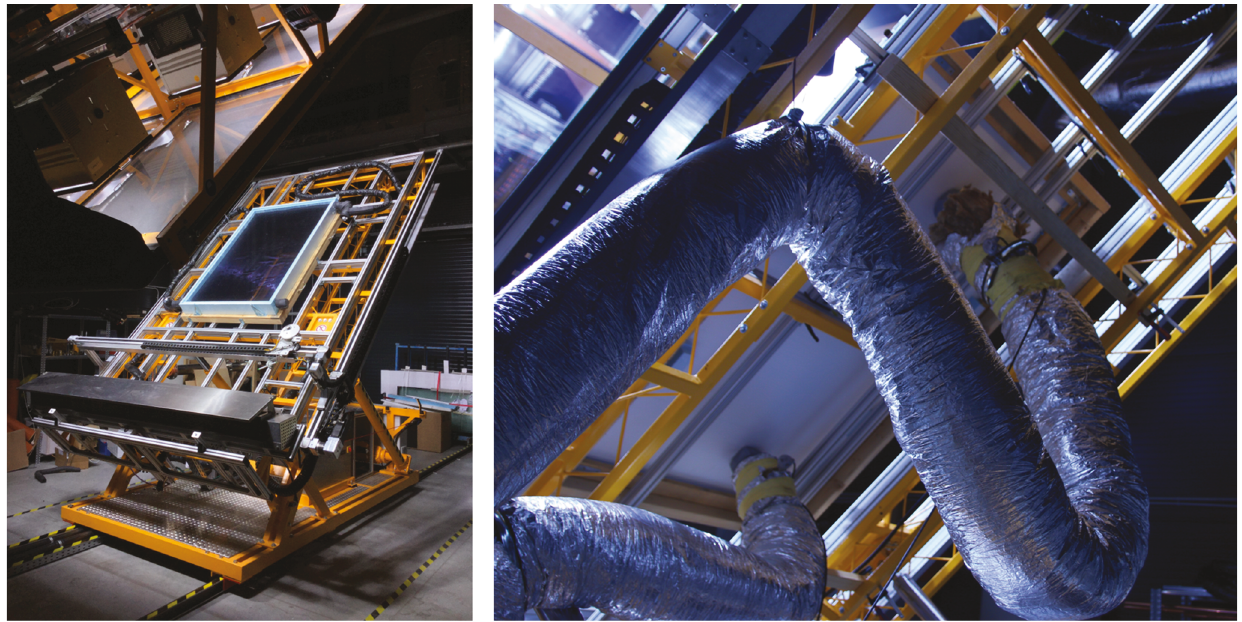
Figure 5: The experimental testing of the liquid and air parts of